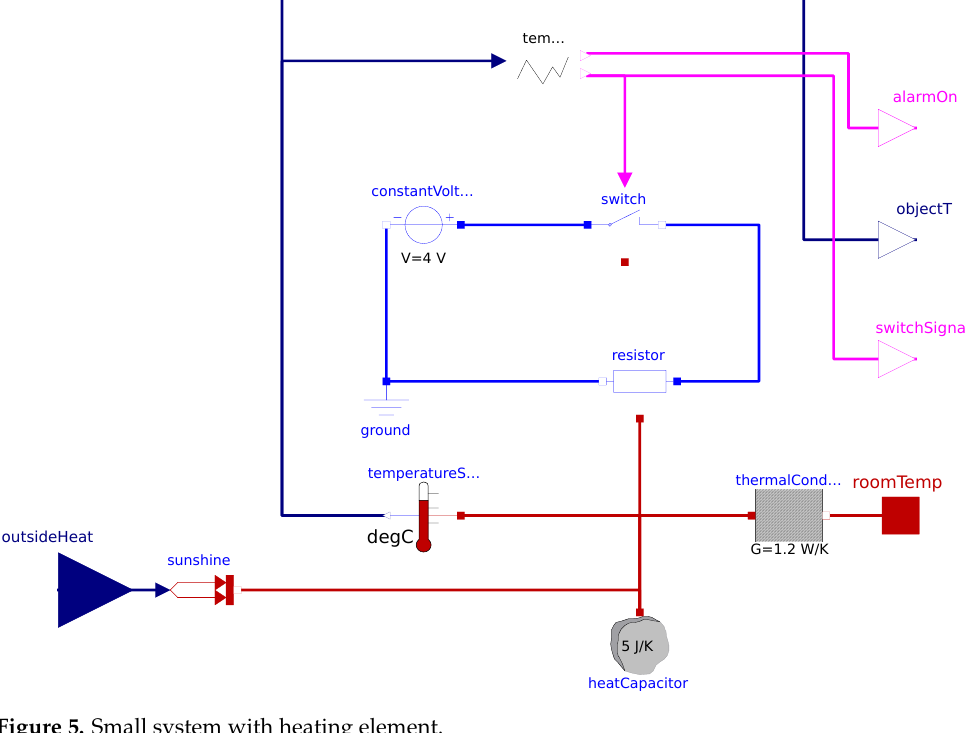
Figure 5. Small system with heating element. Figure 6 shows the overall structure of the package.